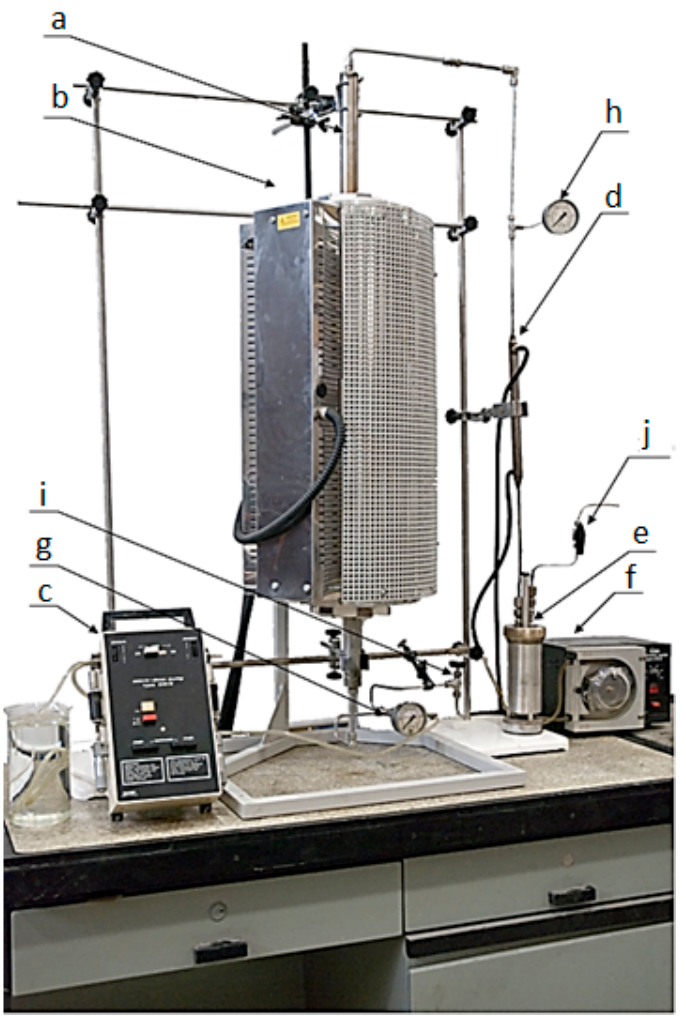
Figure 1. An experimental laboratory setup developed for the coal gasification: a—reactor, b—furnace, c—water pump piston, d—syngas cooler (heat exchanger), e—condensate tank, f—pump supplying the heat exchanger, g—manometer at inlet, h—manometer at outlet, i,j—inlet and outlet valves.